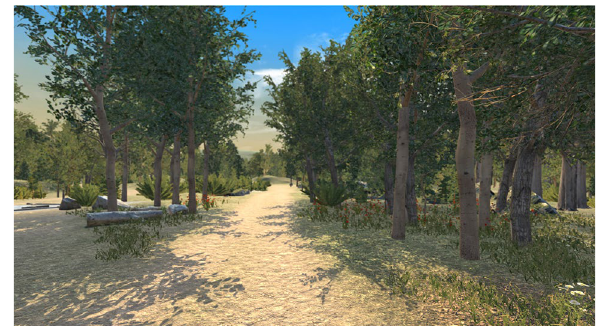
Figure 1. Nature